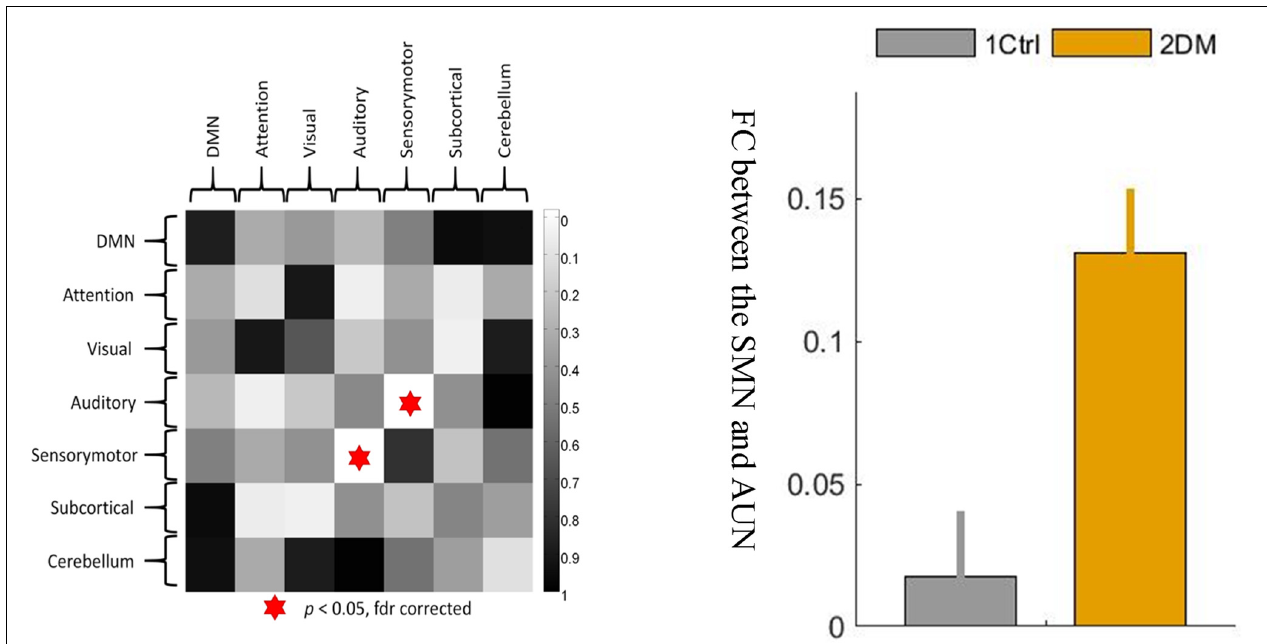
FIGURE 3 | The between-network connectivity strengths between the sensory-motor network and the auditory network were significantly greater at the network level in the T2D group than in the control group. 1 ctrl: the first group is the control group; 2 DM: the second group is the type 2 diabetes group. The error bars in the figures represent the